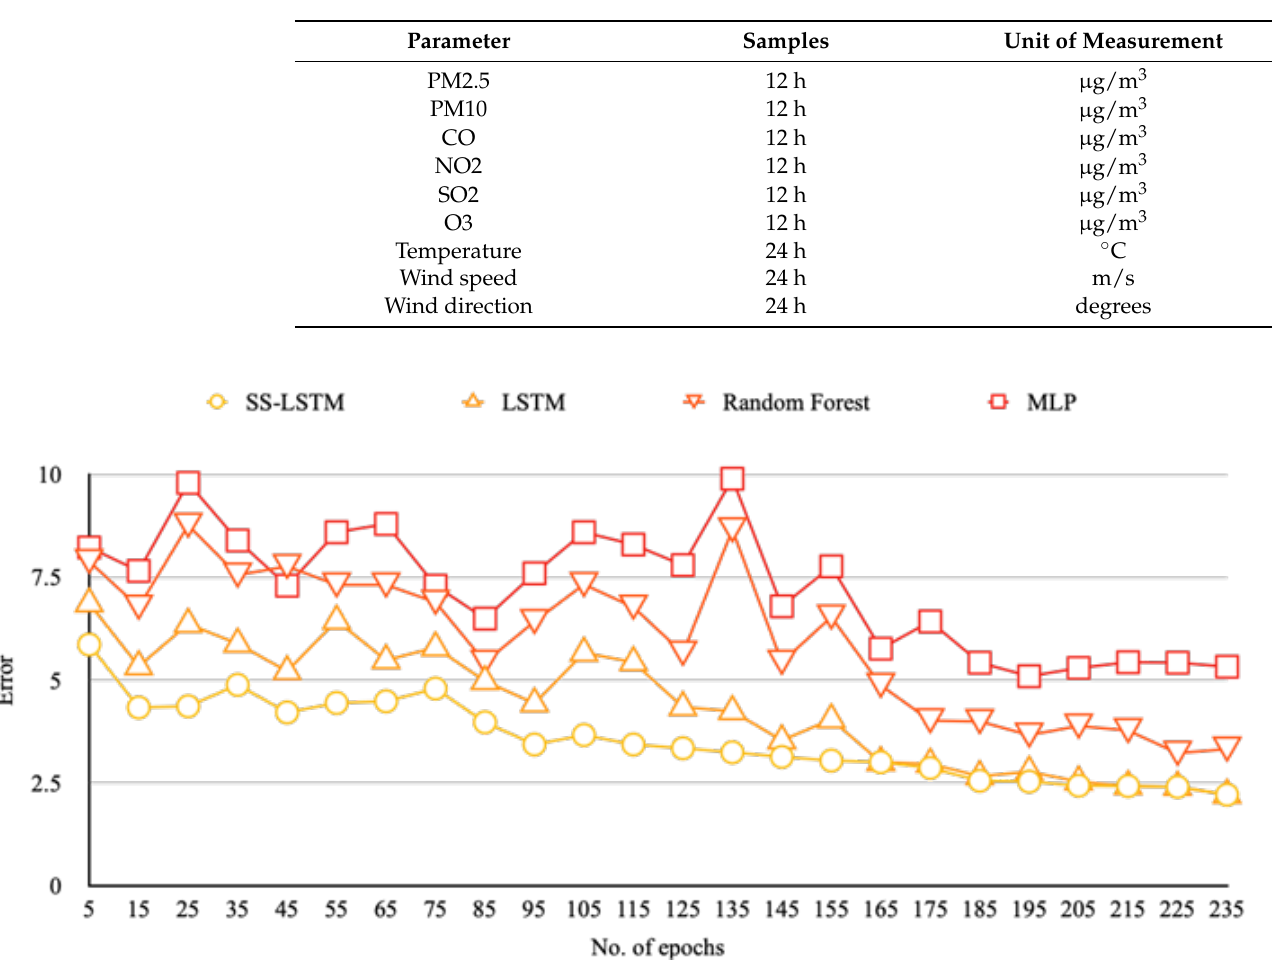
Table 2. Data collected from the CPCB and its unit of measurement.